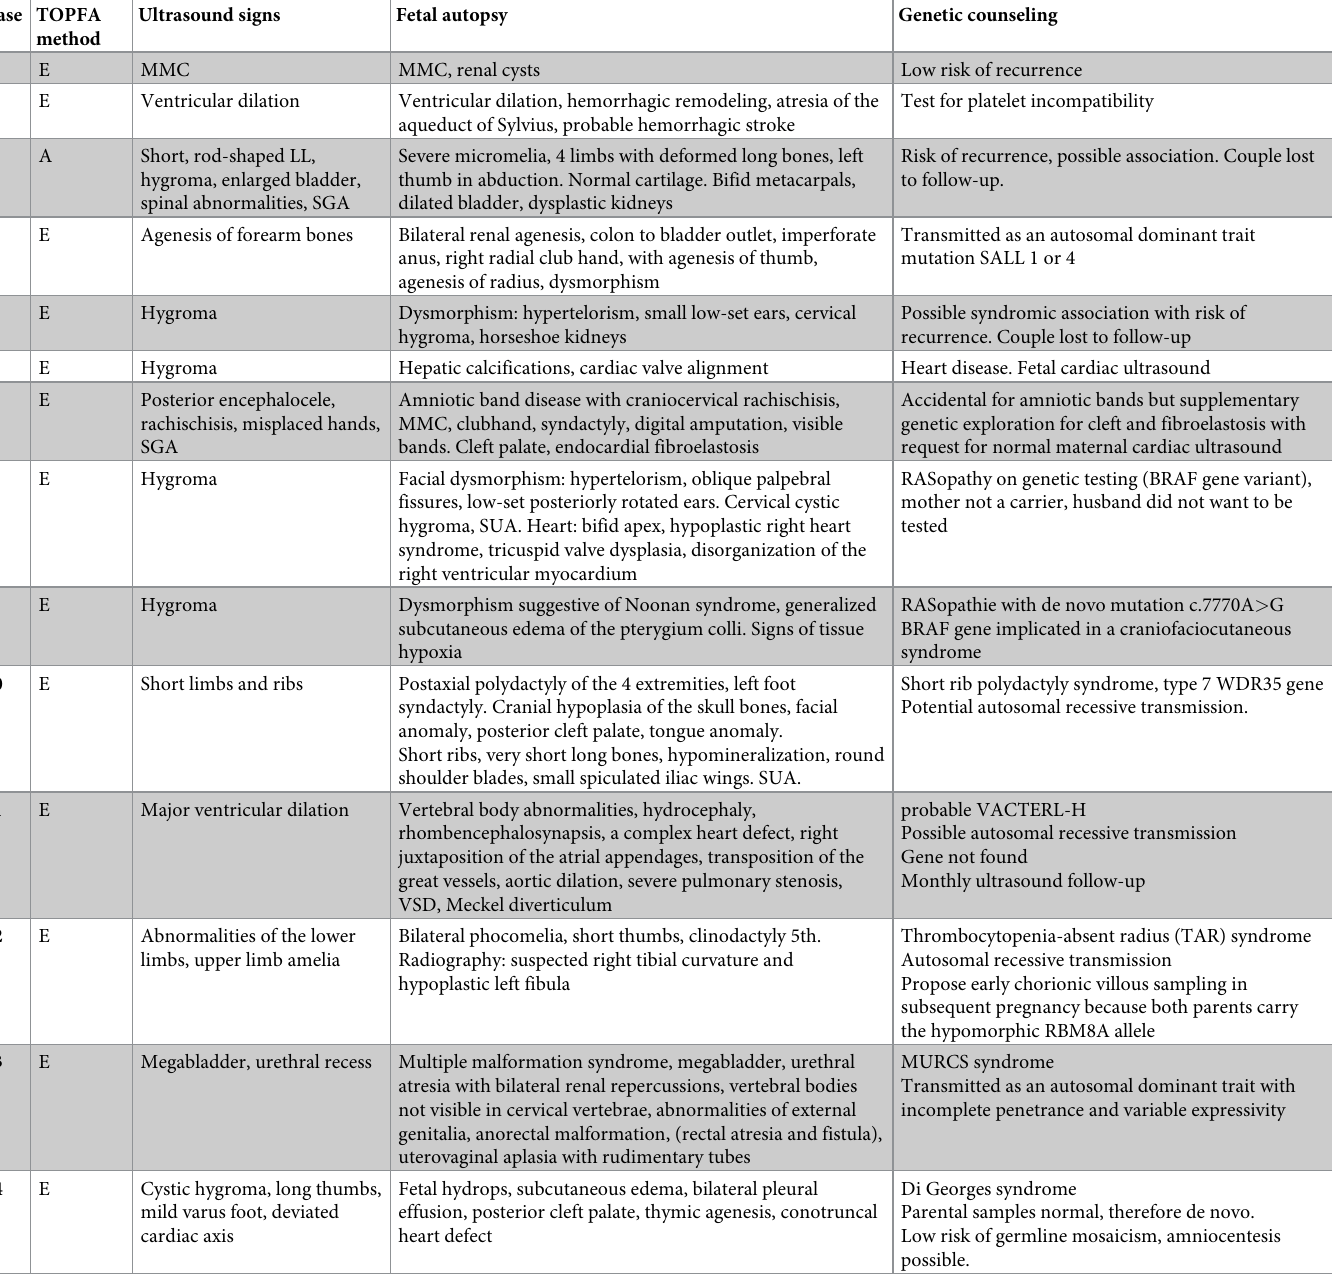
Table 3. Modifications of genetic counseling after fetal autopsy following early TOPFA. Case TOPFA